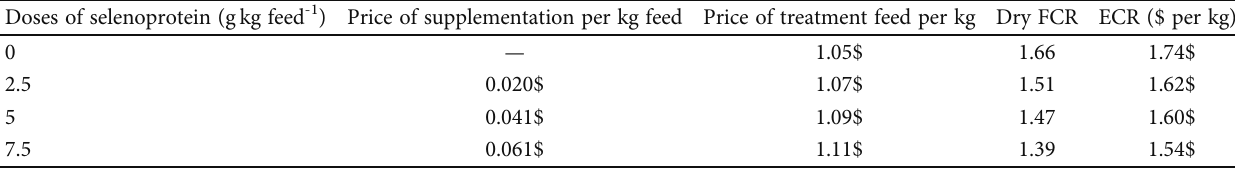
Table 4: Economic conversion ratio (ECR) of each selenoprotein